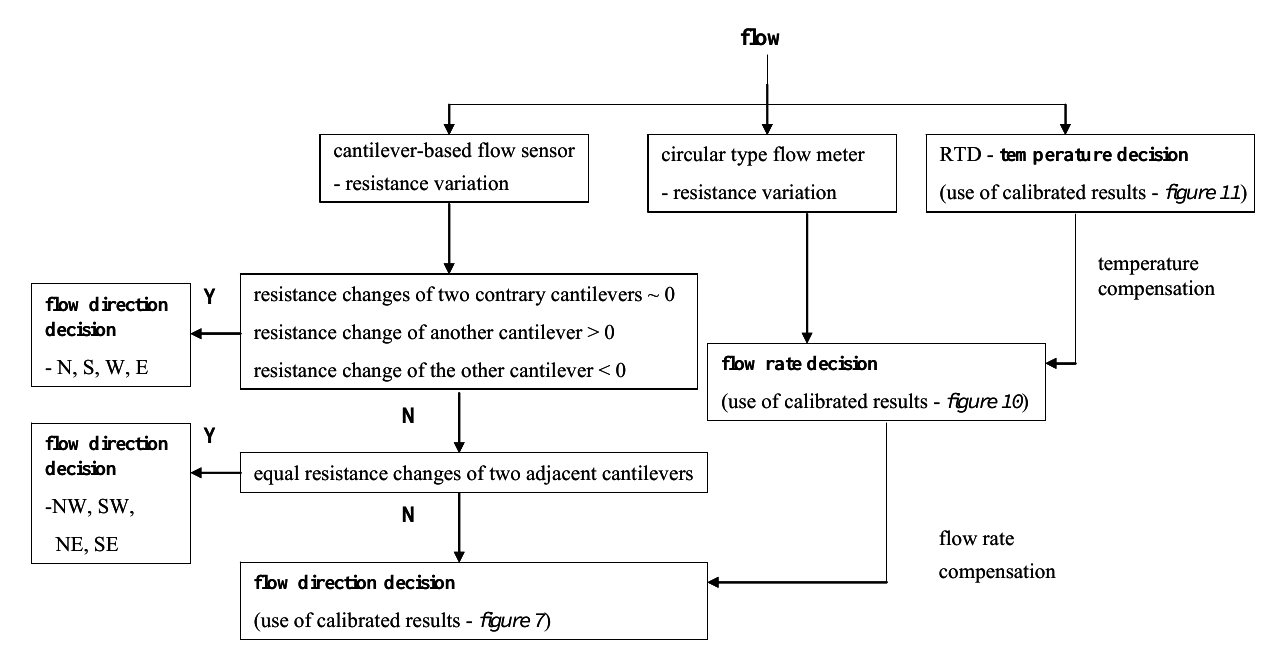
Figure 12. Flow chart of sensing platform operation.